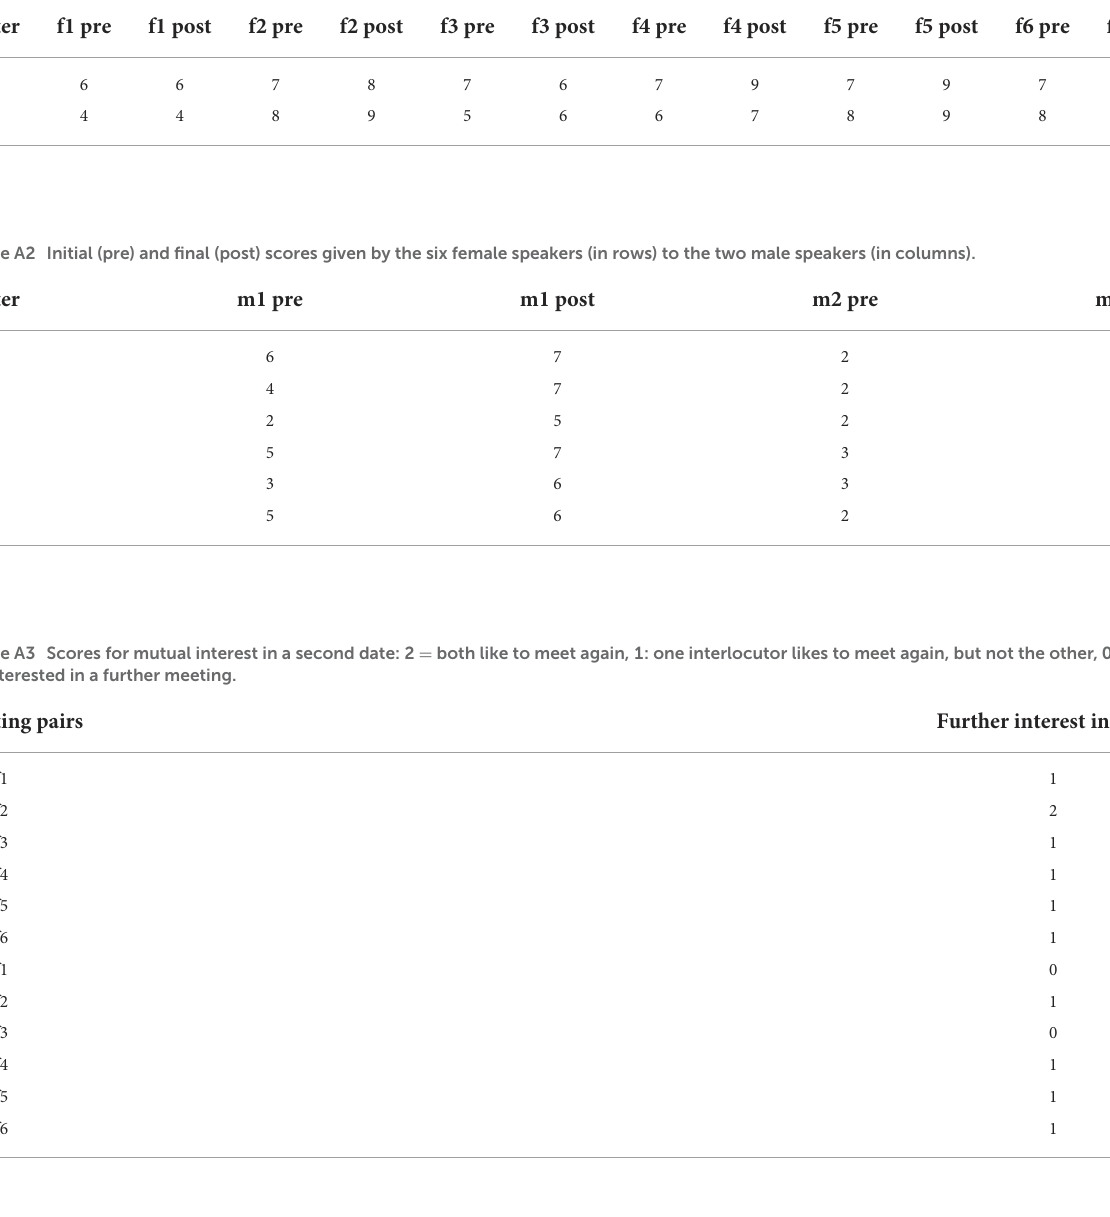
Table A1 Initial (pre) and final (post) scores given by the two male speakers (in rows) to the 6 female speakers (in columns).